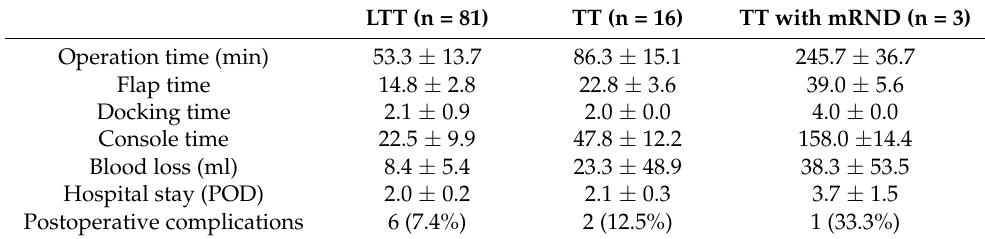
Table 2. Perioperative outcomes according to the extent of operation.